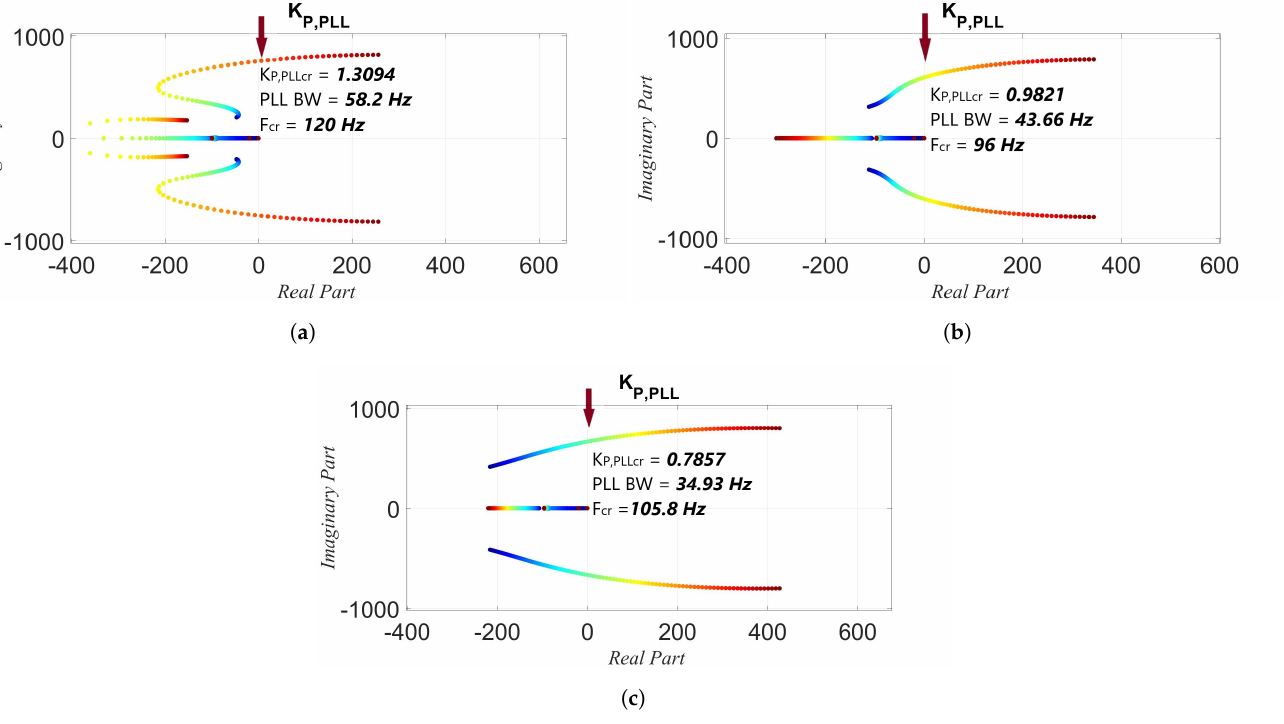
Figure 7. Eigenvalue − based stability analysis for different AVC filter cases in the weak grid case scenario (SCR = 1.5). The critical bandwidth of the PLL is identified after K P , PLL 0 varies from 0.1 (deep blue) to 10 (deep red) times. ( a ) f AVC,LPF = 20 Hz ( b ) f AVC,LPF = 50 Hz ( c ) f AVC,LPF = 100